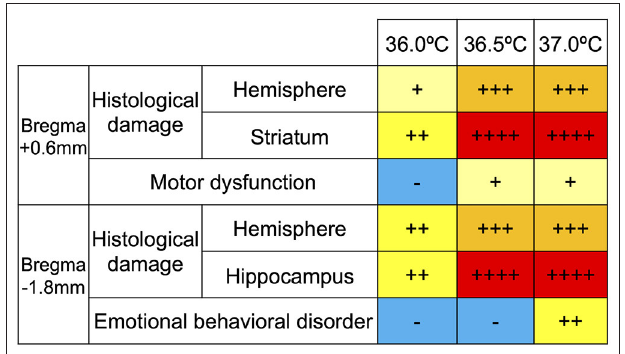
FIGURE 7 | Grade of temperature dependent cerebral volume loss and behavioral dysfunction. The histological damage to the striatum and hippocampus were expressed in four grades ( + , ++ , + + + and + + ++ ) in each temperature group. The levels of disturbance in motor function and emotional behavior were classified into three grades (–, + , and ++ ) in each temperature